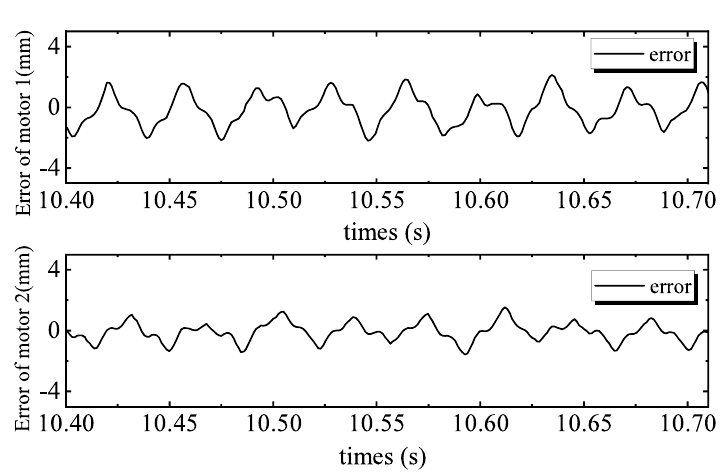
Figure 7. ARC tracking performance of two motors.